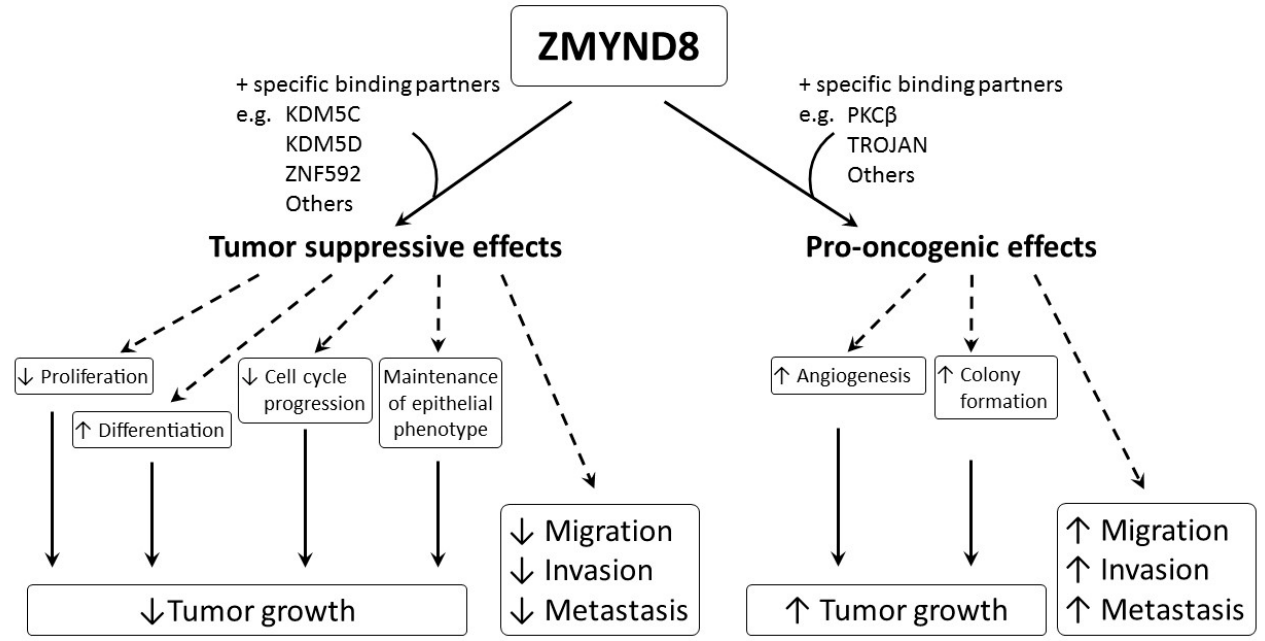
Figure 5. Diagram showing the pro-oncogenic and tumor-suppressive effects of ZMYND8 in cancers. The functions of ZMYND8 were considered through the interaction between ZMYND8 and a specific ZMYND8-binding partner. The ↑ indicates enhancement, and ↓ indicates suppression.